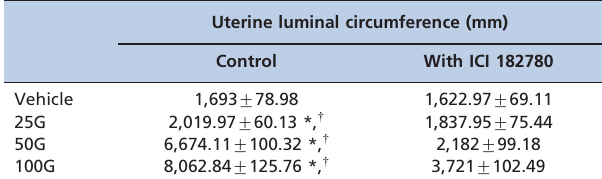
Table 1 - Measurement of the circumference of the uterine lumen in ovariectomised rats treated with peanut oil (control) and different doses of genistein (25, 50 and 100 mg/kg/day) with and without ICI 182780. The values represent the mean ¡ SEM, with n = 6 per treatment group. The circumference was increased with increasing doses of genistein. Administration of ICI 182780 reduced the uterine circumference in all genistein-treated groups.